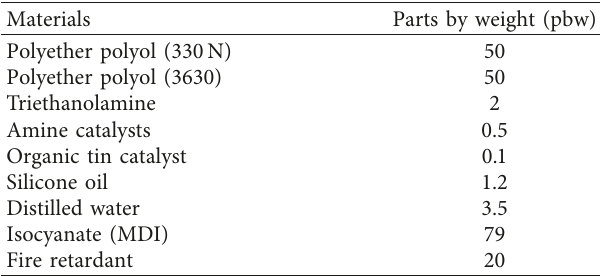
Table 1: Parameters of flame retardant SPUF. Materials Parts by weight